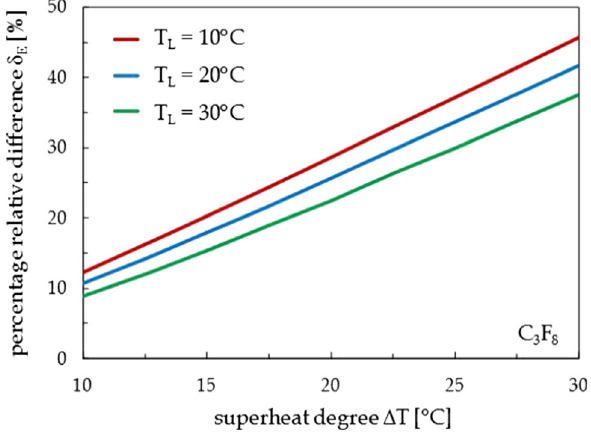
Fig. 7 Distributions of δ E = ( E c − E ∗ c )/ E c vs. (cid:4) T for C 3 F 8 using T L as a